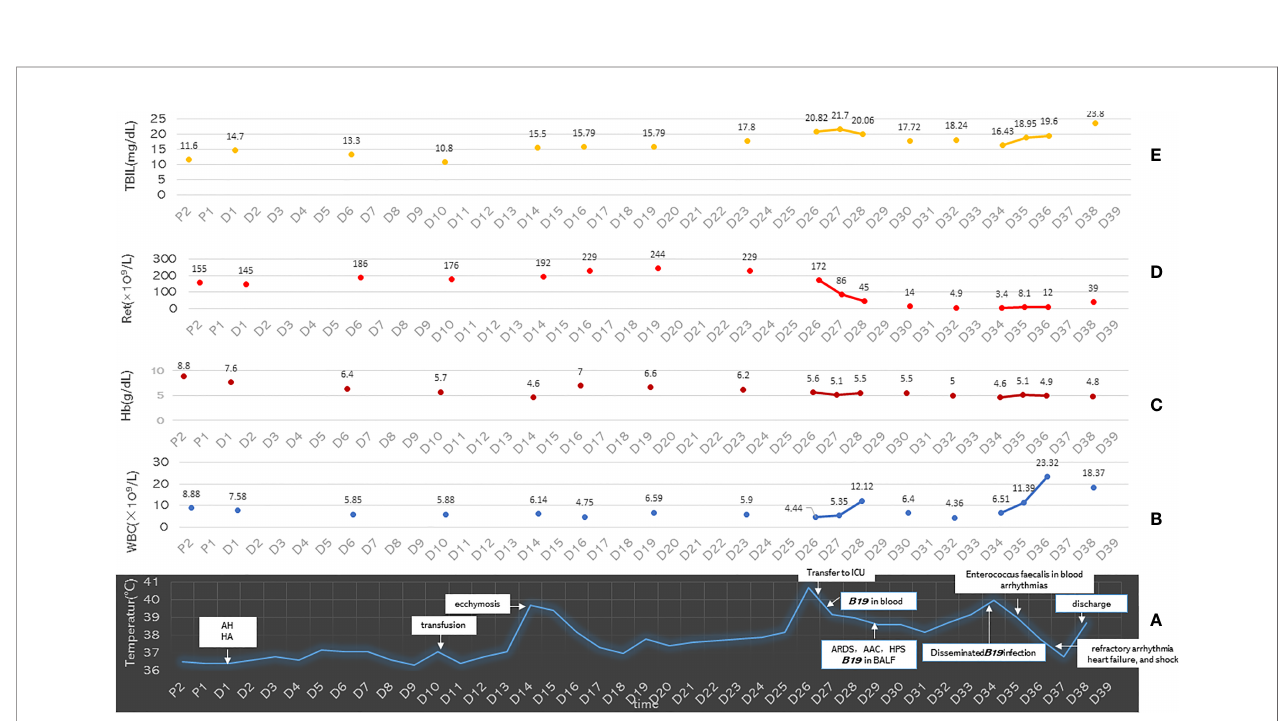
FIGURE 3 | (A) The distribution of the main clinical events and body temperature of the patient on the time axis. (B – E) The Ret count, Hb, WBC, and TBIL values of the patient on the time axis. P1, day 1 pre-hospital; P2, day 2 pre-hospital; D1 to D39, day 1 to day 39 of hospital admission; AH, alcoholic hepatitis; HA, hemolytic anemia; ARDS, acute respiratory distress syndrome; HPS, hemophagocytic syndrome; AAC, acute aplastic crisis; Ret, reticulocytes; Hb, hemoglobin; WBC, white blood cell; TBIL, total bilirubin.